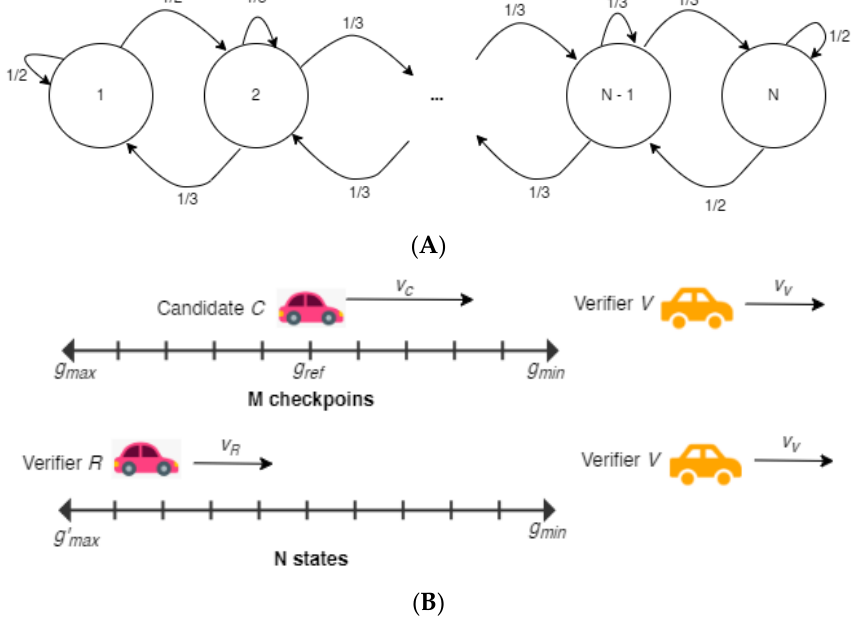
Figure 8. ( A ) Acceleration; ( B ) Velocity; ( C ) Following distance.